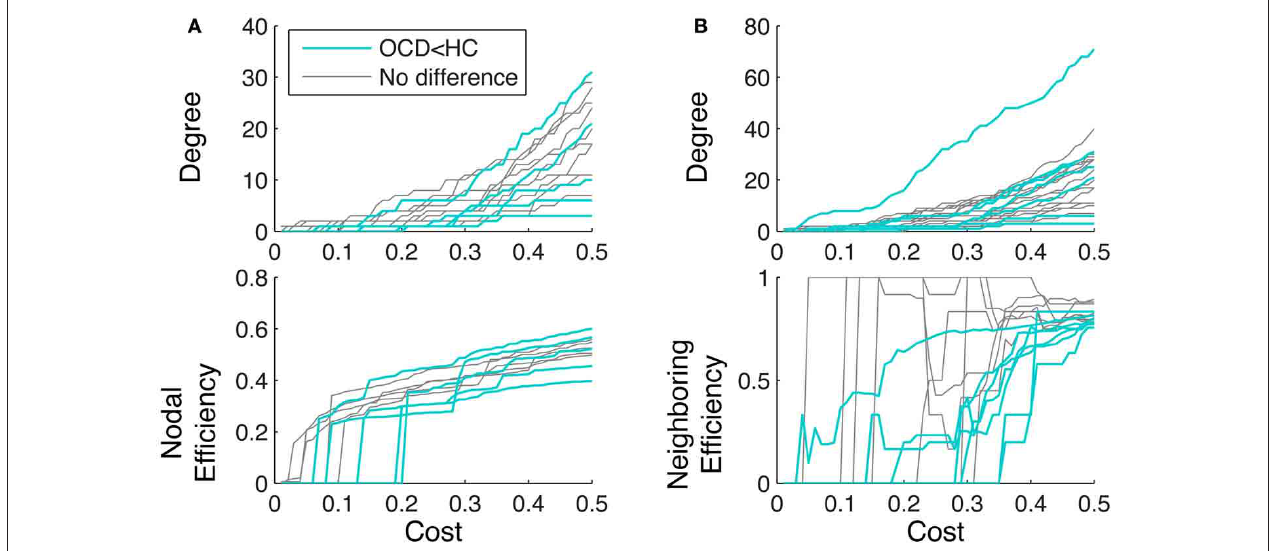
similar mean degrees are also shown (gray). The nodes with smaller efficiency in OCD than healthy controls exhibits different growth of efficiency even though the mean degrees are similar to the other nodes in OCD.